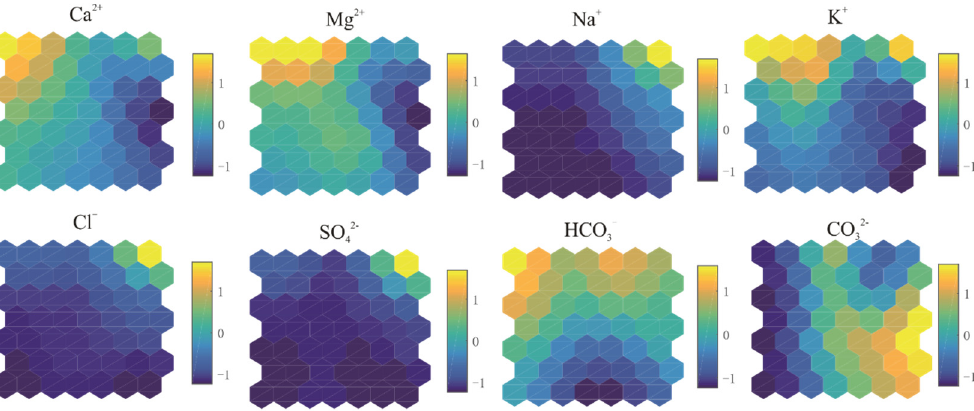
Figure 9. SOMs for the groundwater in the study area.